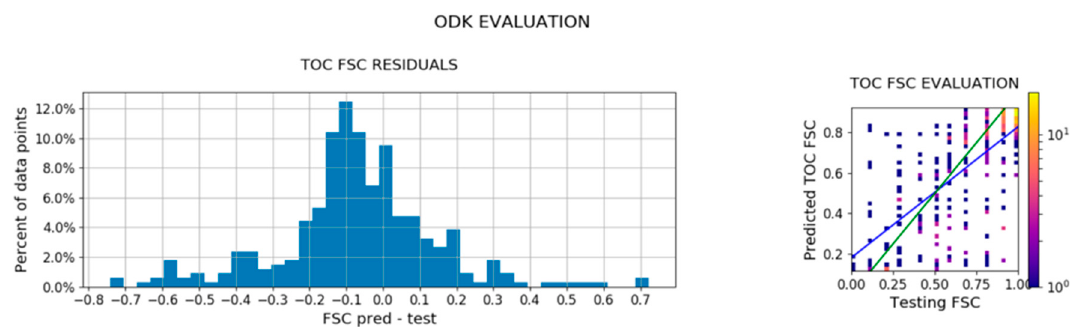
Figure 10. Results of the evaluation of the FSC using ODK data. Blue line: Linear regression between the predicted and the testing FSC sets. Green line: 1:1 line. The color bar indicates the number of samples by bin.